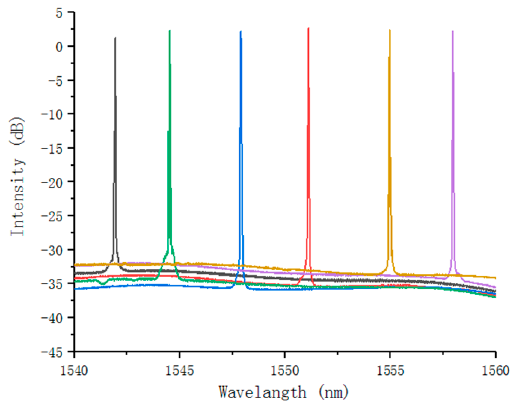
Figure 6. Coarse tuning characteristics of fiber laser in the range 1542–1558 Figure. 6. Coarse tuning characteristics of fiber laser in the range 1542–1558 nm.